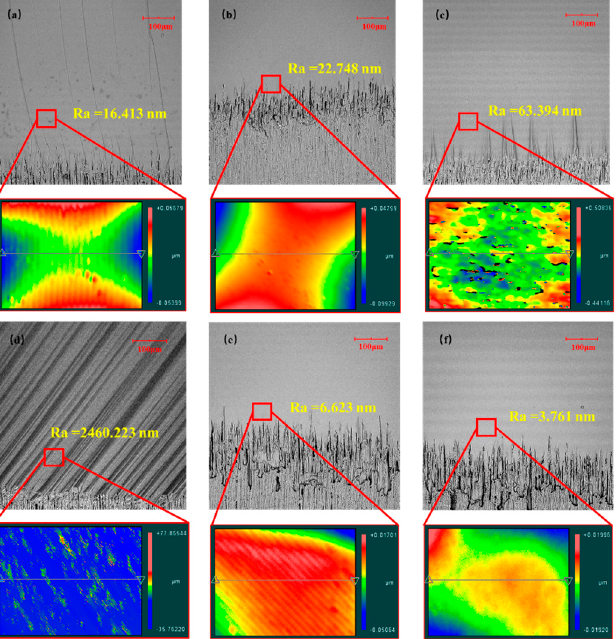
Figure 11. The roughness of the fracture section. ( a ) Test 1-M-A; ( b ) Test 2-M-C; ( c ) Test 3-C-M; ( d ) Test 4-C-A; ( e ) Test 5-A-C; ( f ) Test 6-A-M.